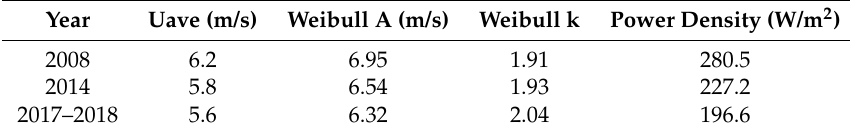
Figure 8. Annual wind speed distributions. Table 6. Annual wind resource and power density